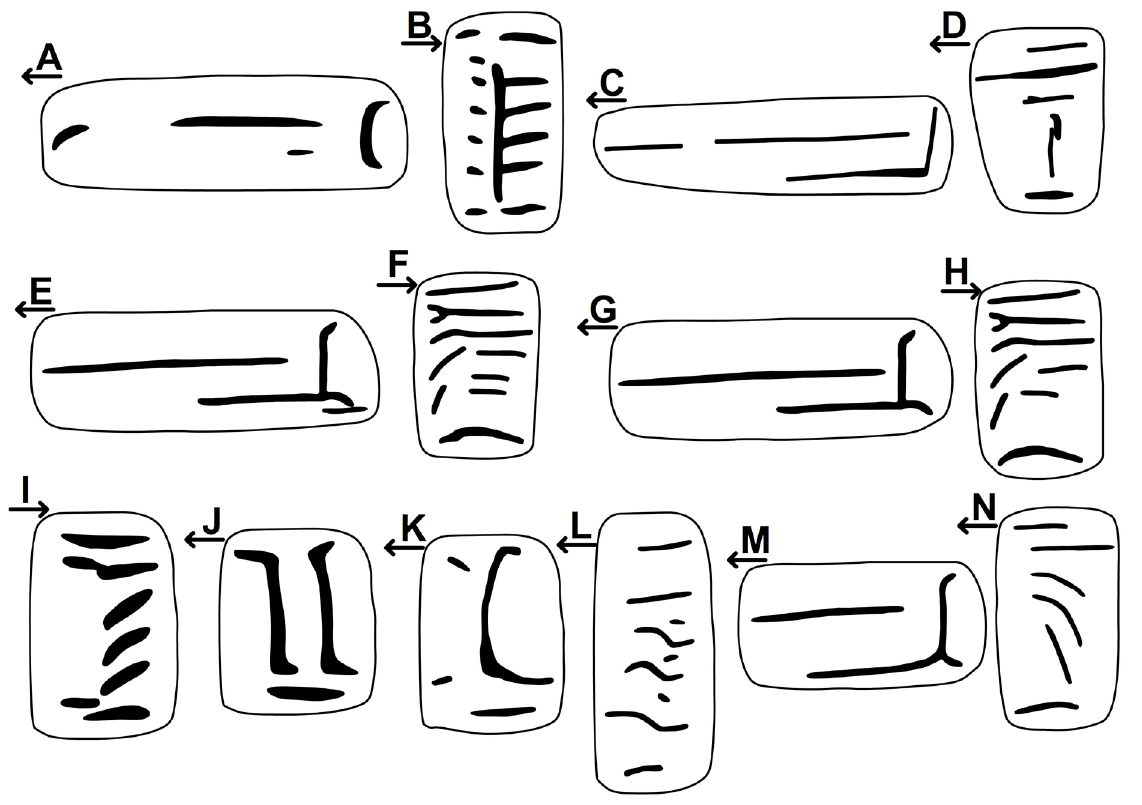
Fig. 7. Parietal (A, C, E, G, J, K, M) and palatal (B, D, F, H, I, L, N) plication in species of